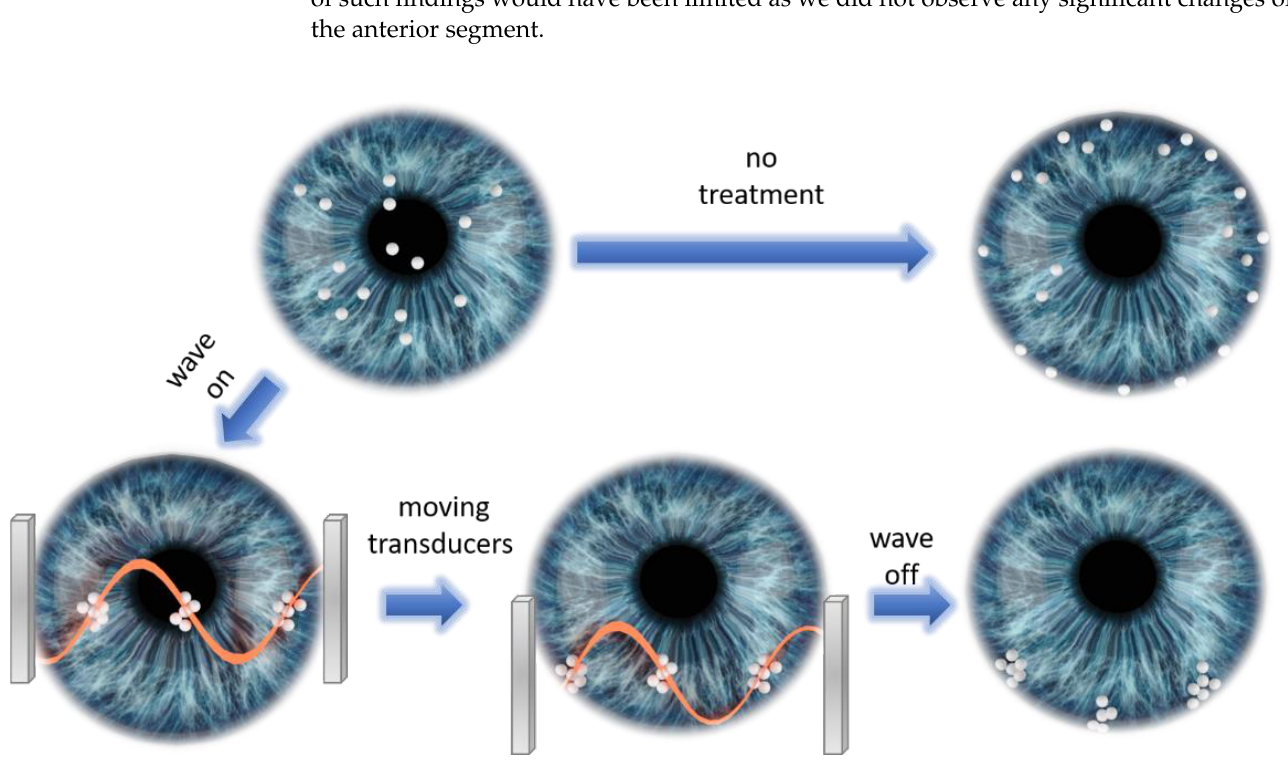
Figure 8. Illustration of suggested protocol utilizing acoustic manipulation for preventing second- ary glaucoma. Without treatment, particles will flow towards the angle and distribute uniformly on the TM. Acoustically trapping particles at nodal areas followed by moving the acoustic transducers leads to placement of trapped particles at specific locations of the angle, thus leaving unaffected areas of TM that can support AH outflow.